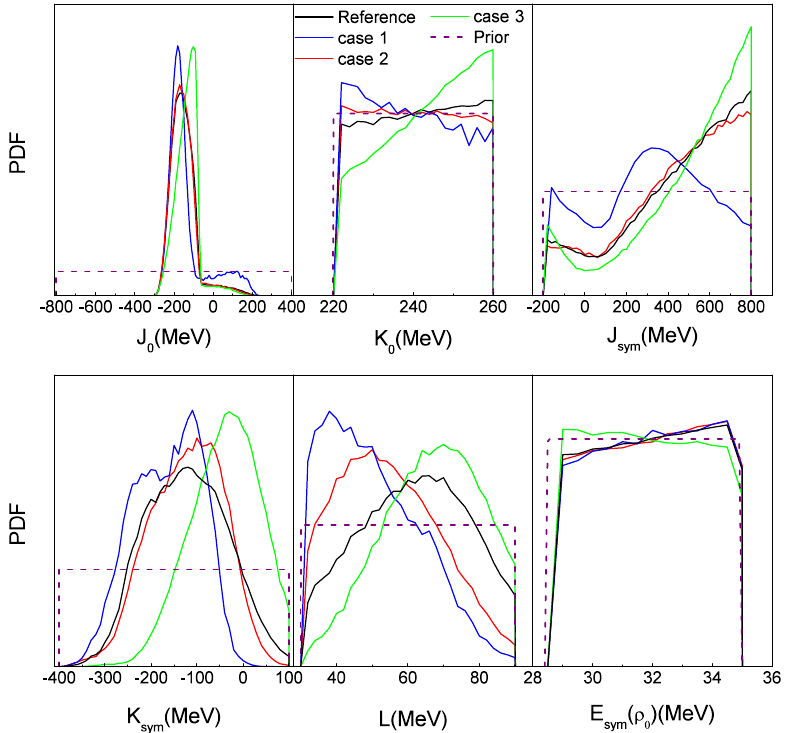
Figure 10. The posterior PDFs of the 6 EOS parameters in comparison with their prior PDFs for the three cases using the mass–radius data shown in Figure 9. Taken from [67].